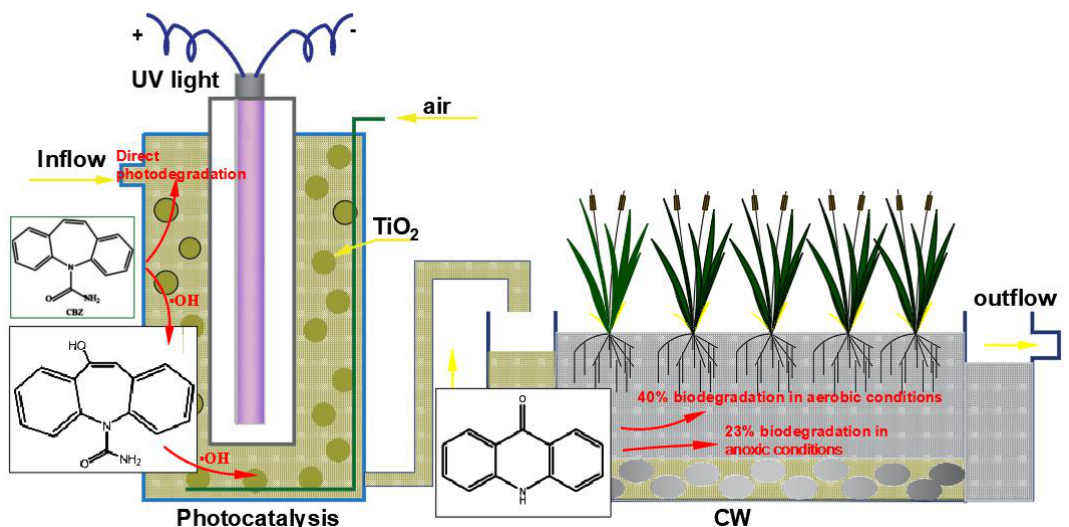
Figure 2. CBZ degraded by CWs combined with photocatalytic oxidation.